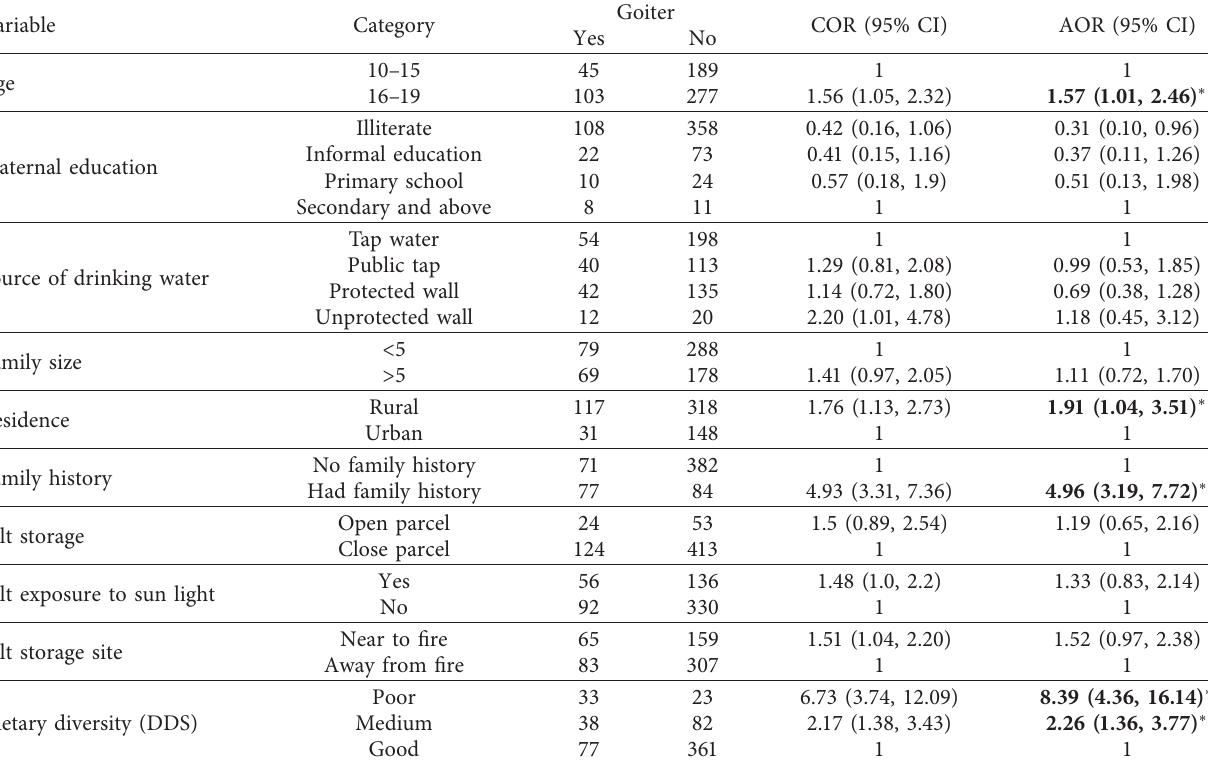
Table 3: Factors associated with goiter among adolescent girls in Tach Armachiho district, Northwest Ethiopia, 2018.